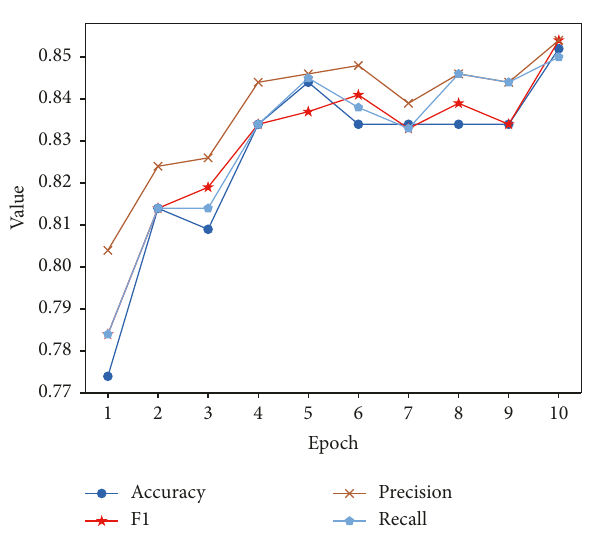
Figure 7: The trend of the loss